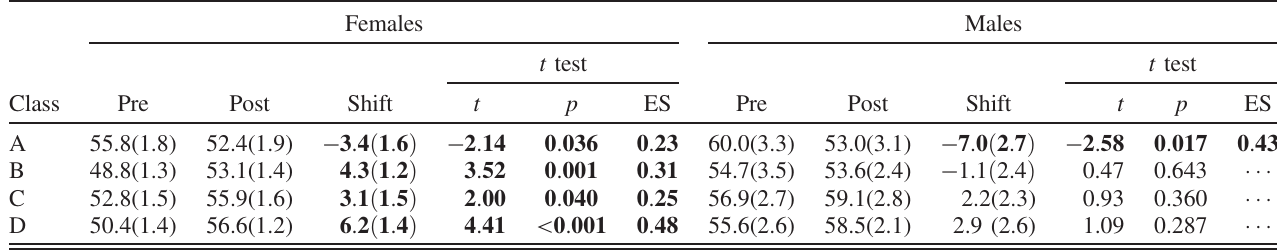
TABLE IV. Differences in overall percent favorable responses and overall shifts between males and females in all four classes ( (cid:2) standard error). Shifts in bold font indicate significance ( p < 0 . 05 ). Paired sample t tests ( t statistics, p values, and effect sizes — ES) are included.